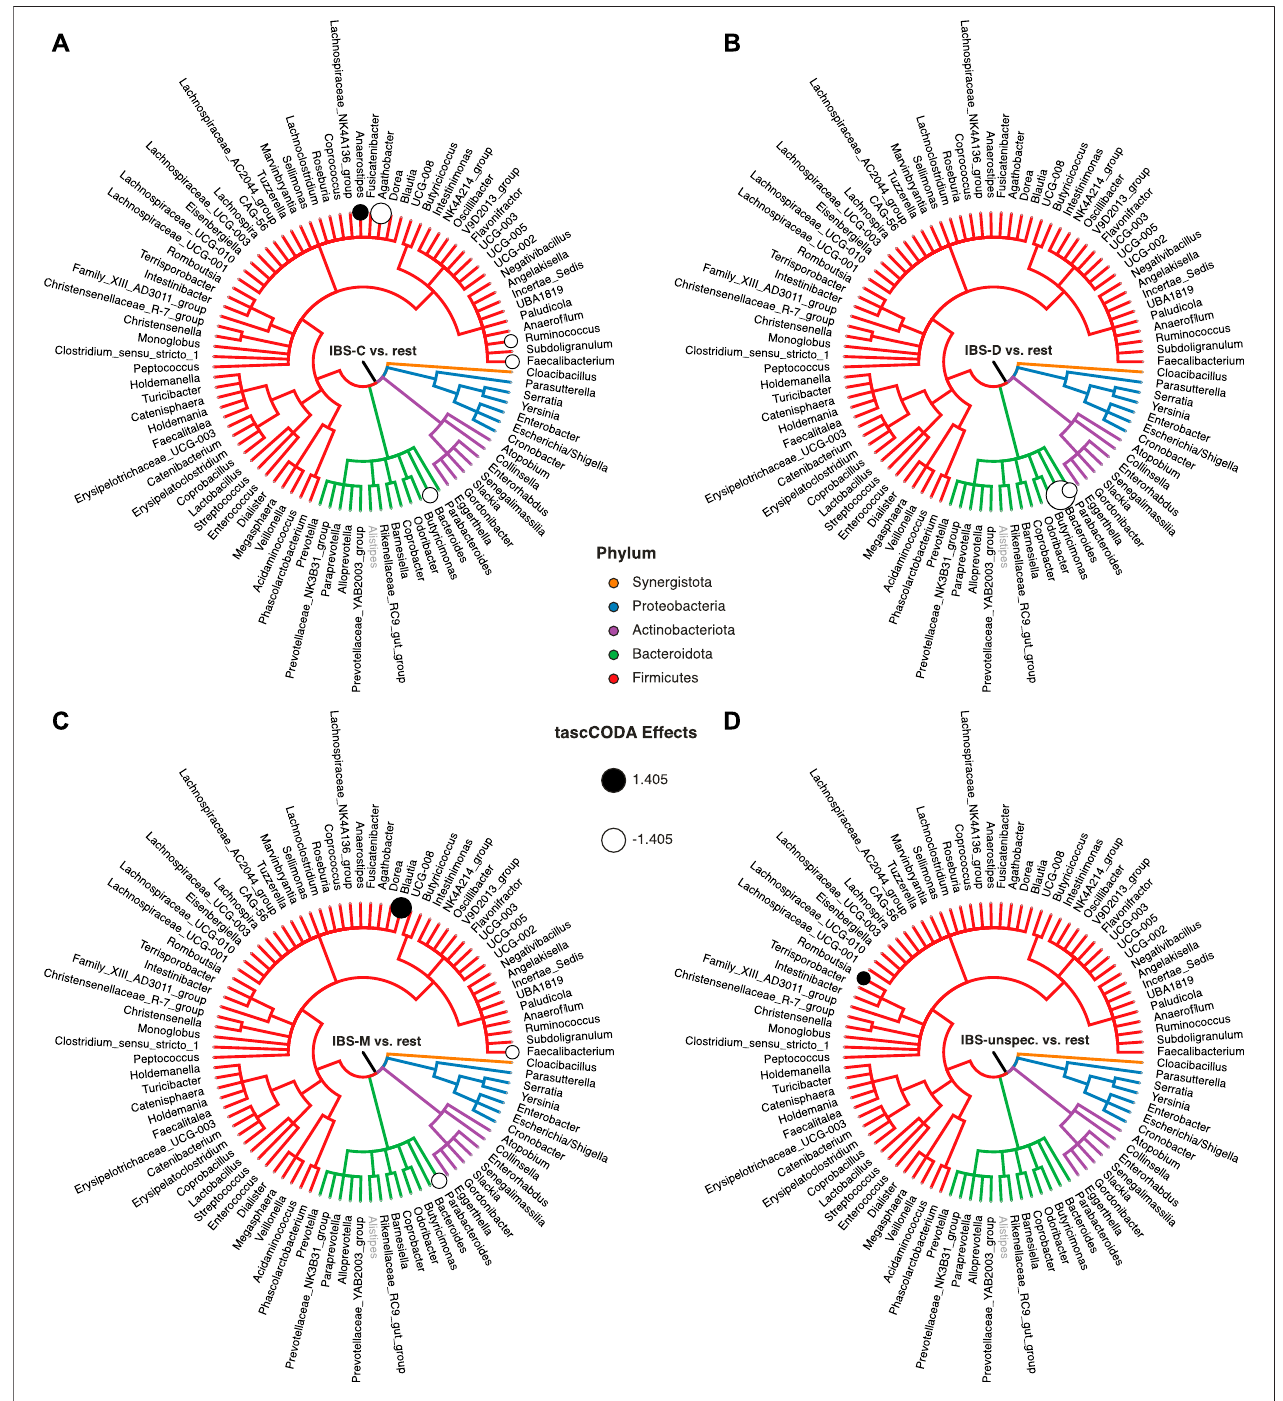
FIGURE 8 | Credible changes found by tascCODA ( λ 1 (cid:2) 1, ϕ (cid:2) 5), simultaneously comparing healthy controls to all IBS subtypes in the genus-aggregated data of Labus et al. (2017). The circles on nodes of the tree represent credible effects. The grey genus Alistipes wasused asthe reference for tascCODA. (A) IBS-C ( n (cid:2) 11). (B) IBS-D ( n (cid:2) 10). (C) IBS-M ( n (cid:2) 6). (D) IBS-unspeci fi ed ( n (cid:2)